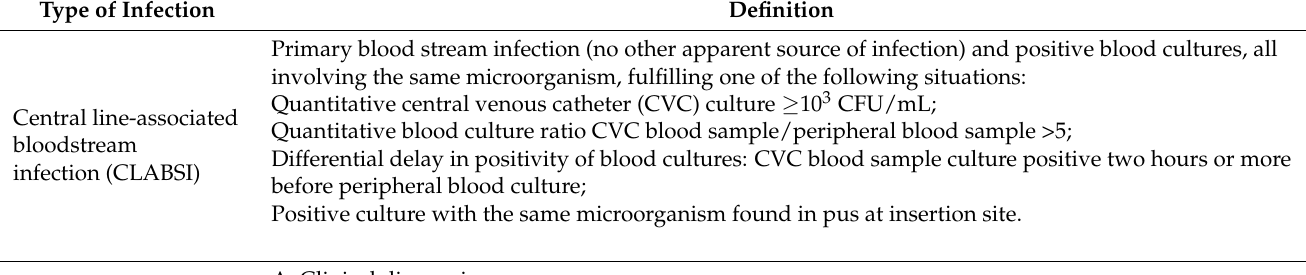
Table 1. Definitions of healthcare-associated infections according to ENVIN-Ped and based on CDC definitions